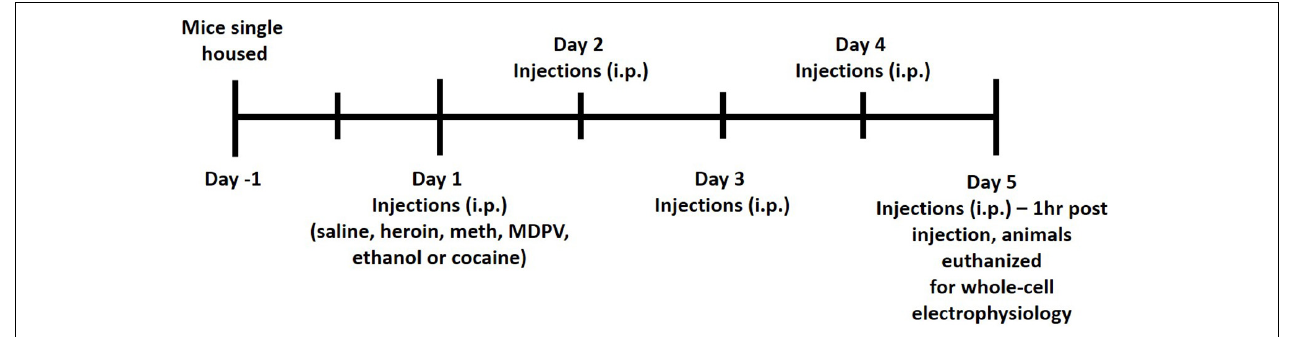
FIGURE 1 | A timeline of experimental